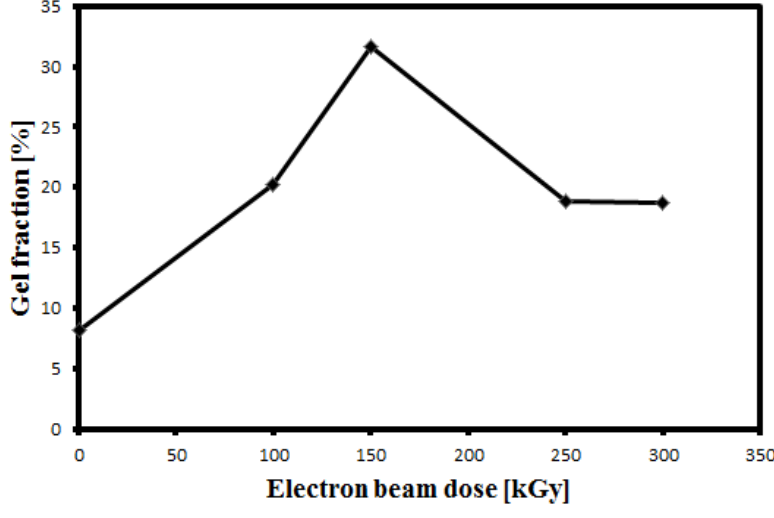
Figure 7. Gel fraction as a function of radiation dose.